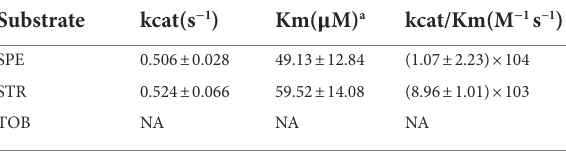
TABLE 5 Kinetic parameters of various aminoglycoside antimicrobials for purified AadA36.